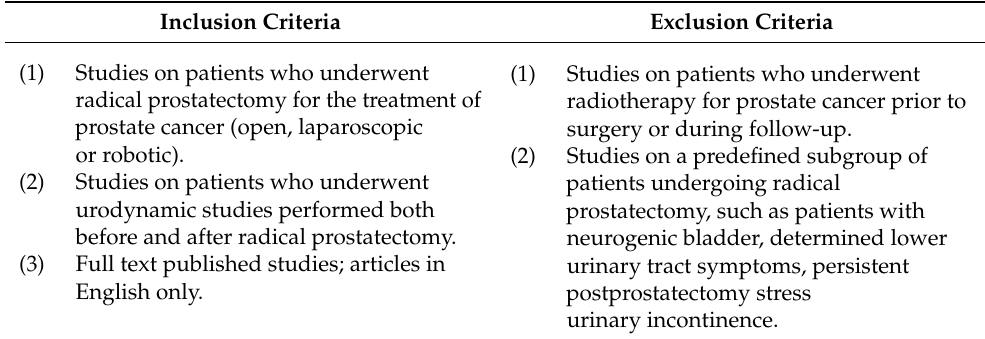
Table 1. Eligibility